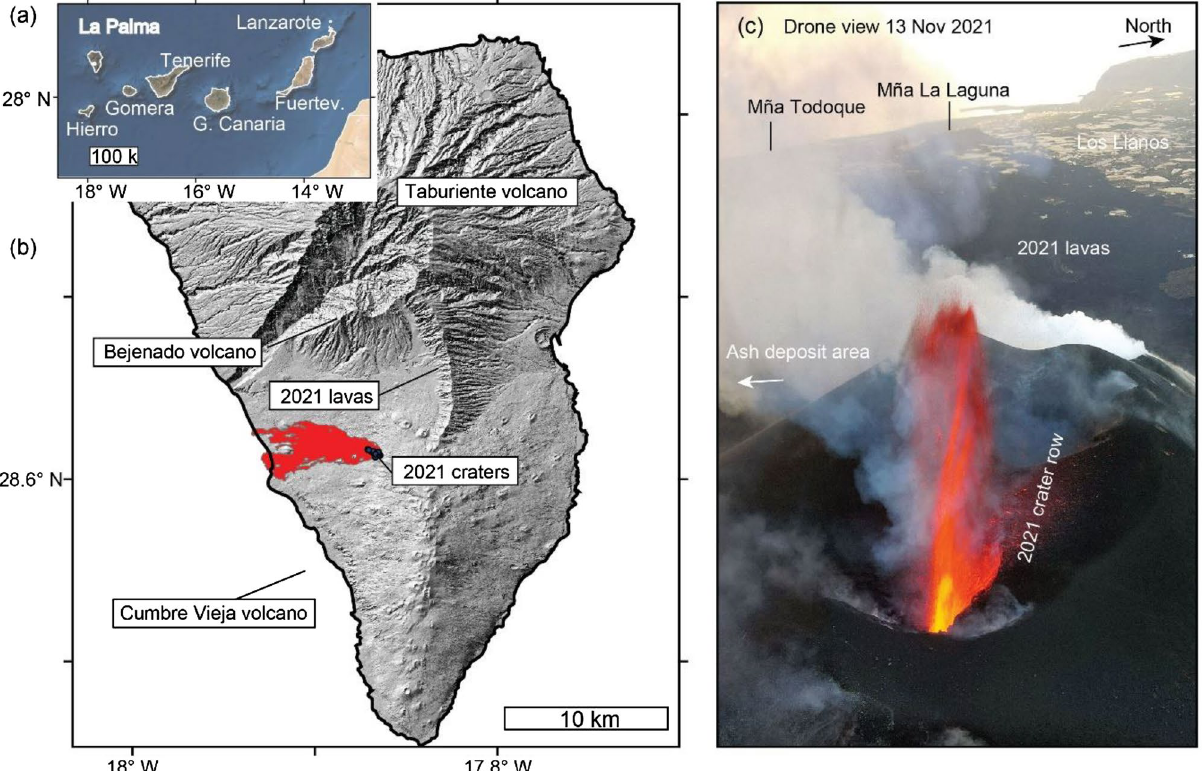
Figure 1. Overview map of the Canary Islands with La Palma in the NW ( a ). Topographic hillshade of La Palma with the 2021 Cumbre Vieja volcano lava field ( b ). Drone view from the active crater area over the lava field towards the western coast of La Palma ( c ). Drone image taken by us during field work on November 13, 2021. Map created using the GMT/MATLAB Toolbox (https:// agupu bs. onlin elibr ary. wiley. com/ doi/ 10. 1002/ 2016G C0067